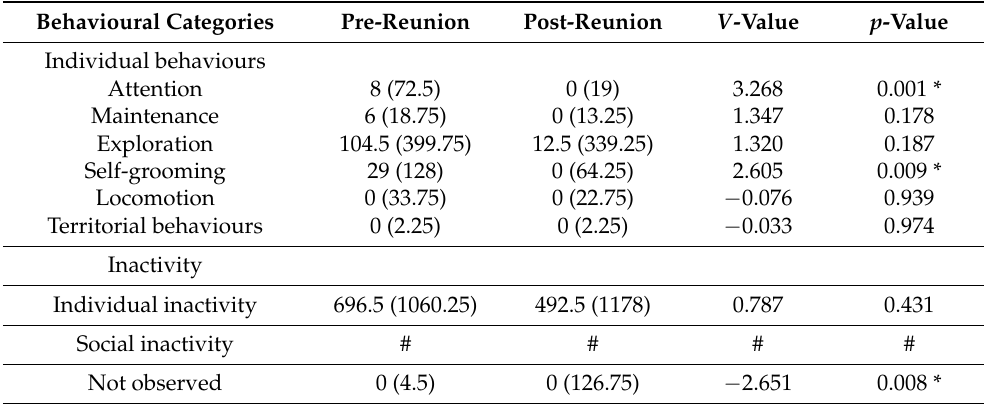
Table 3. Behavioural categories performed by wildcats during the pre-reunion and the post-reunion period. For each behavioural category, the table reports the median (IQR) duration in seconds. Moreover, V and p values of the Wilcoxon test from the comparison between the two periods are also reported. Asterisks indicate significant difference ( p < 0.05). # Not enough data.